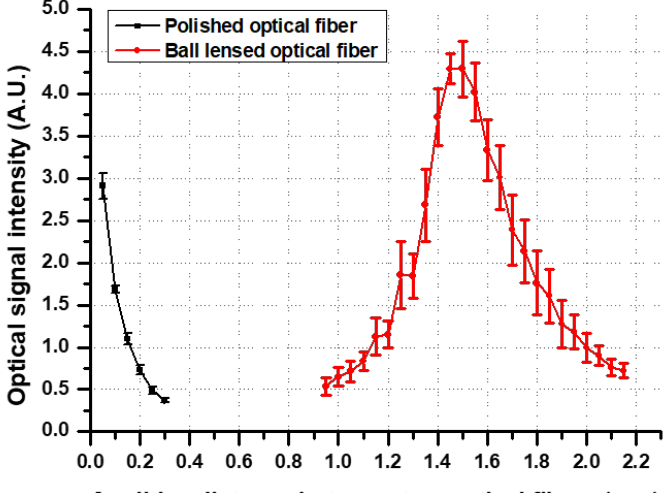
Figure 5. Results of the detected optical signal intensities using the ball-lensed optical fiber (BLOF) and the polished optical fiber.